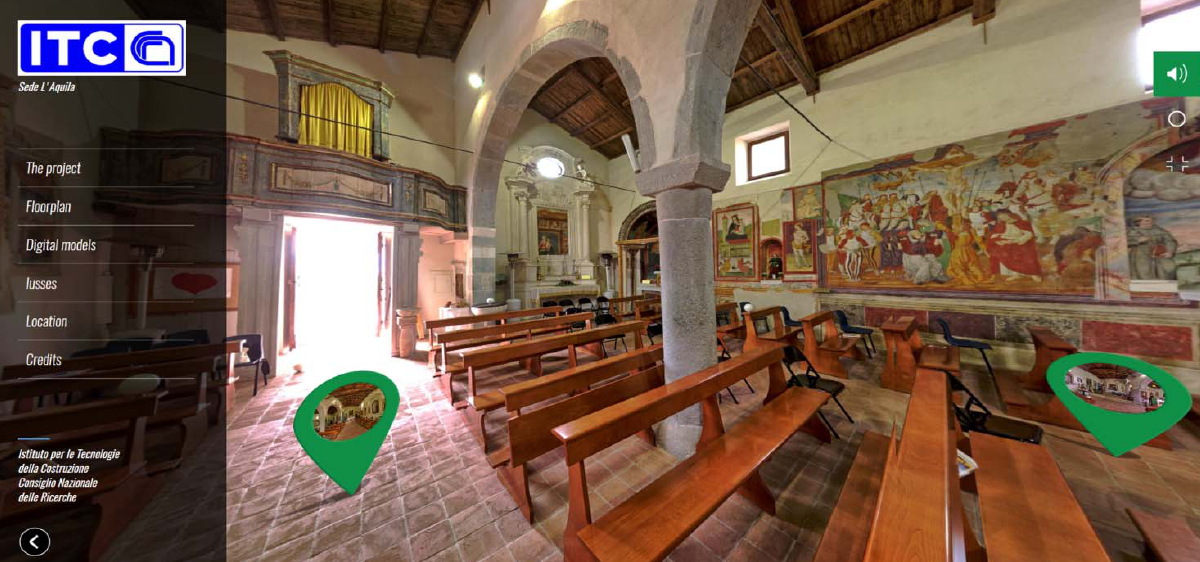
Figure 8. Virtual tour screenshot, in which are highlighted the hotspots, to move around the church, the audio content, active, and the